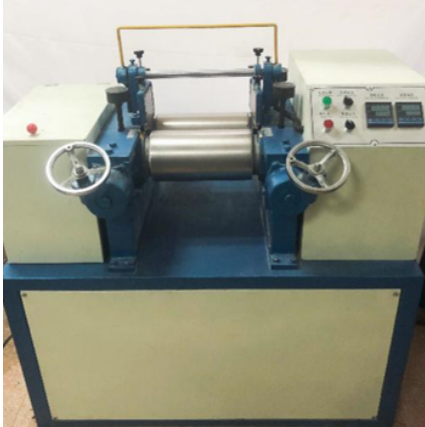
Figure 3: The twin roller mill.